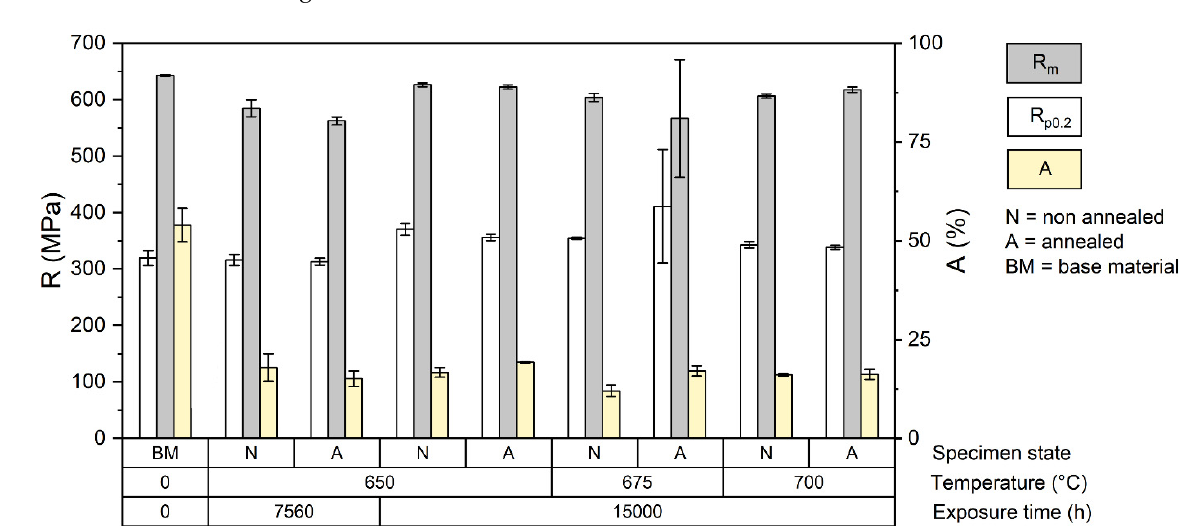
Figure 4. Results of the tensile test at RT of the weld joint